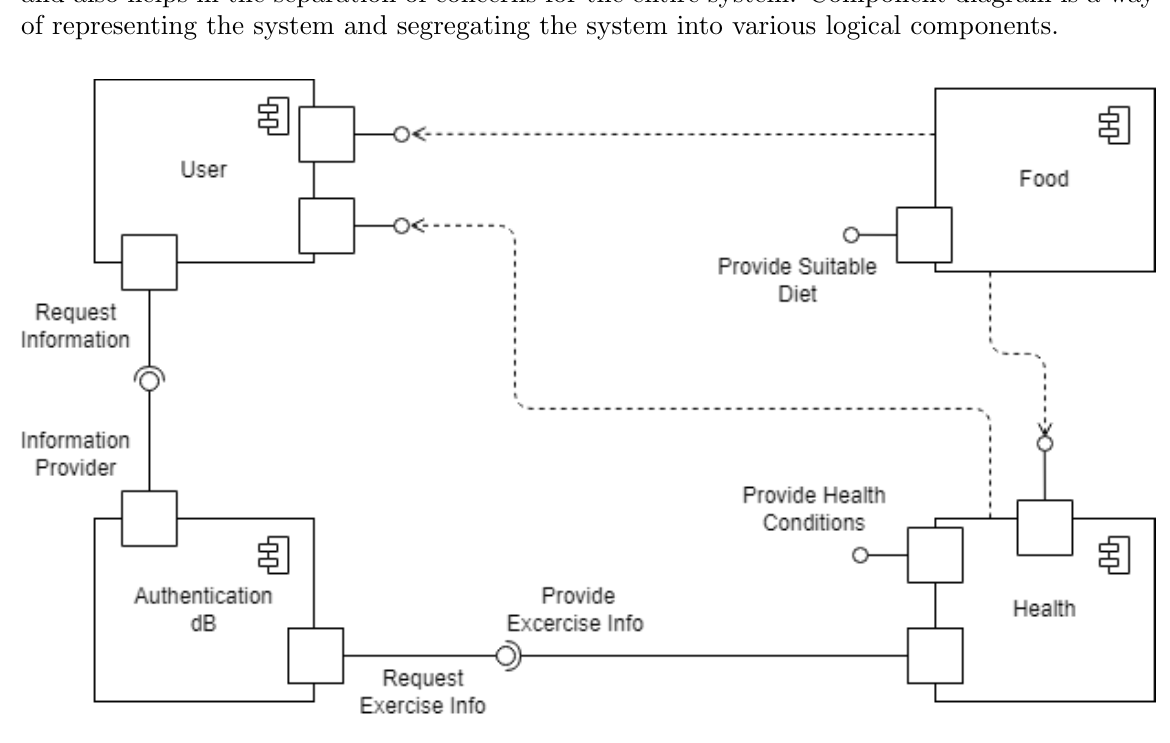
Figure 14. Component Diagram of Proposed